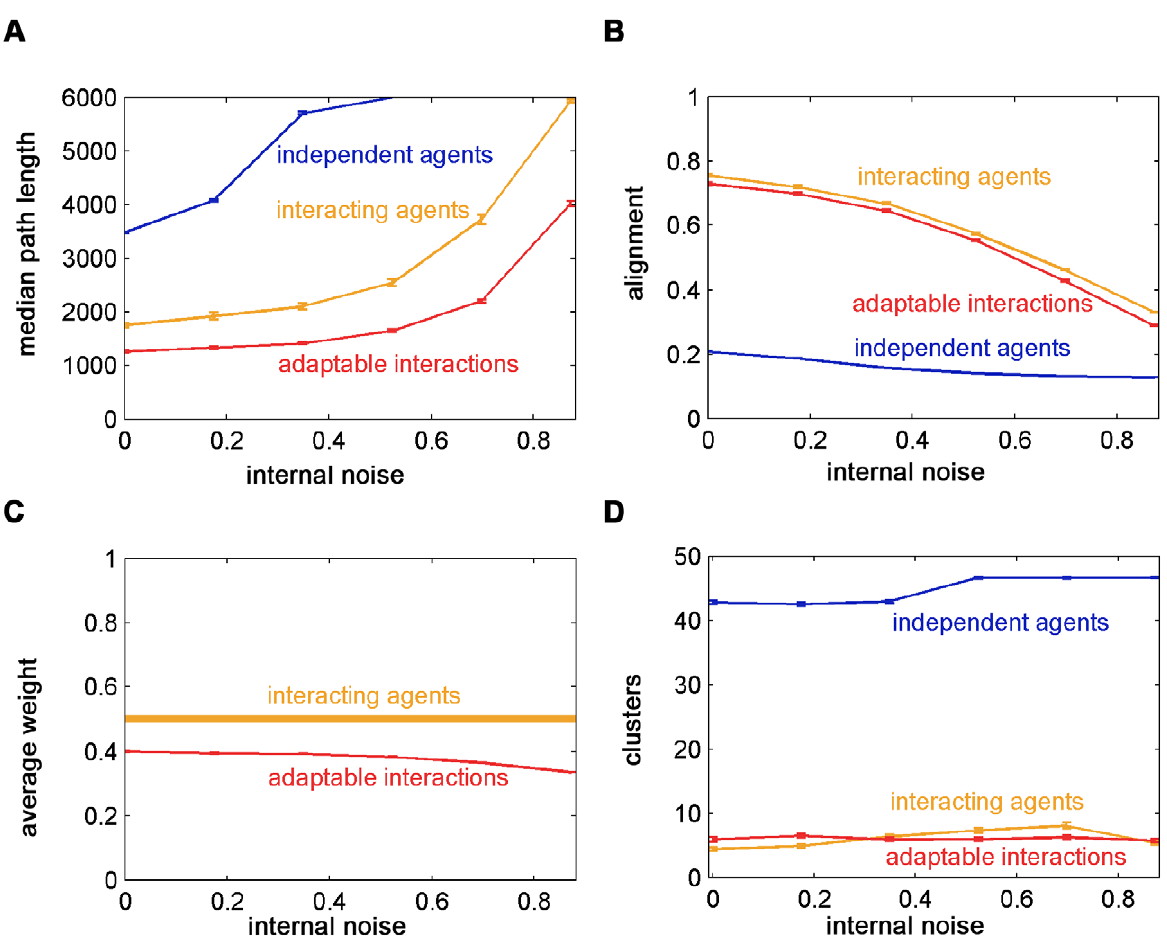
Figure 11. The effect of internal noise on group behavior. A. Diversity in the agents’ movements resulting from internal noise causes an increase of median path lengths among all the mechanisms. The effect on the independent agents is the most devastating and groups did not complete the task by the end of the simulation. The effect on the interacting agents is larger than the effect on agents with adaptable interactions. B. Group alignment decreases with s . For independent agents, alignment decreases due to the individual loss of biased motion towards the target because of the noise. C. The average weight of agents with adaptable interactions, which is lower than the constant predefined weight of the interacting agents, reduces further with s , implying groups become more conformist. D. Clustering is weakly affected by s . Independent agents are more clustered due to loss of biased motion. Interacting agents become slightly more clustered with s . Agents with adaptable interactions are generally slightly more clustered than interacting agents but their clustering is not affected by s . Simulation parameters are as in Figure 8, apart from s . Error bars represent standard error.